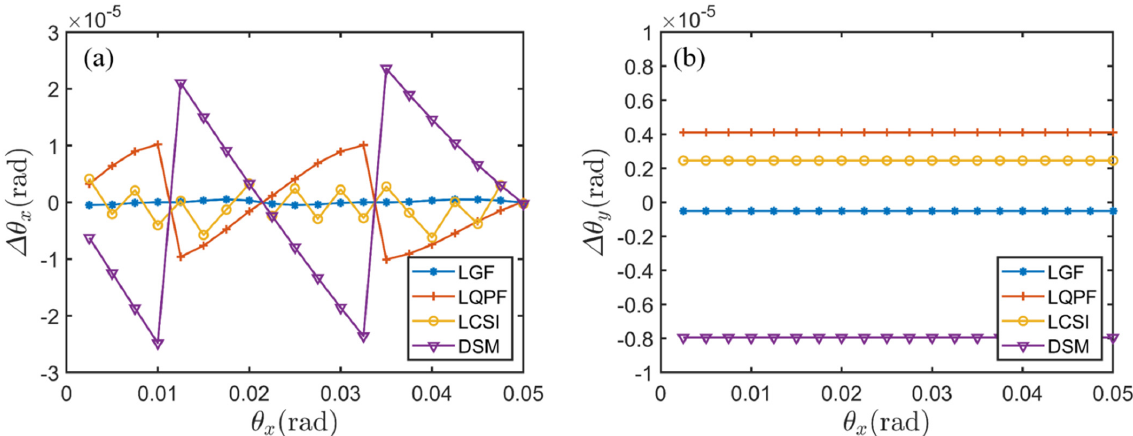
Figure 5. Comparison of the result from LGF with that from other RTA evaluation methods after zero-padding operation. ( a ) Δθ x and ( b ) Δθ y distributions from four methods when θ y = 0.025 rad.